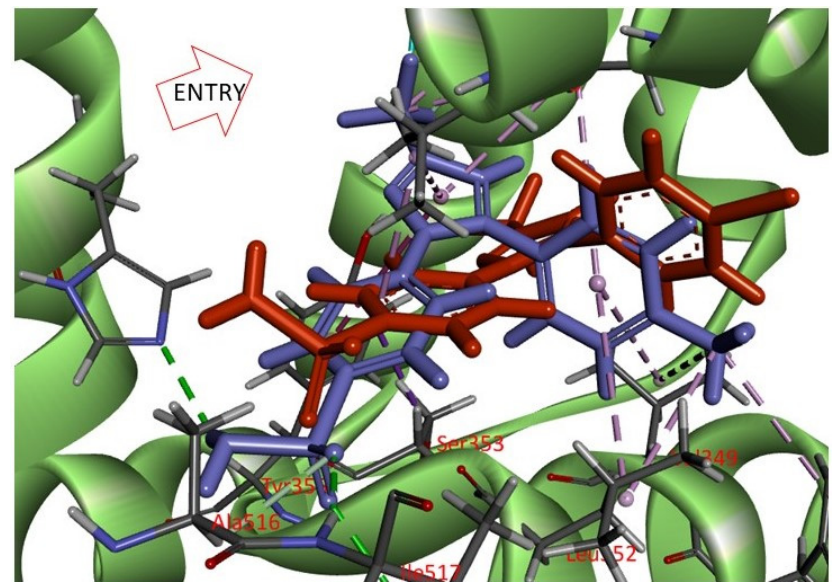
Figure 12. Overlaying of bromocelecoxib (SC558) pose retrieving from PDB data base (1CX2) with celecoxib from the docking result. Original pose from PDB specified in blood red and the pose from docking result marked in purple. RMSD = 6.615 Å .